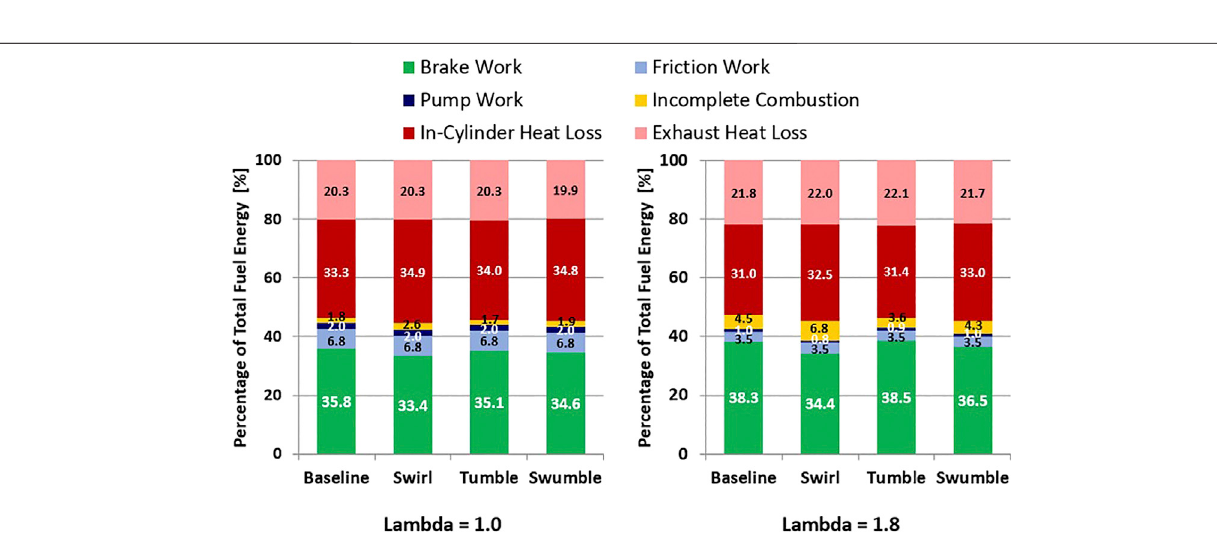
right plot. Practically, this means that the variation in the peak pressure generated in the pre-chamber by the pre-chamber combustion event induces variation in main chamber combustion performance.